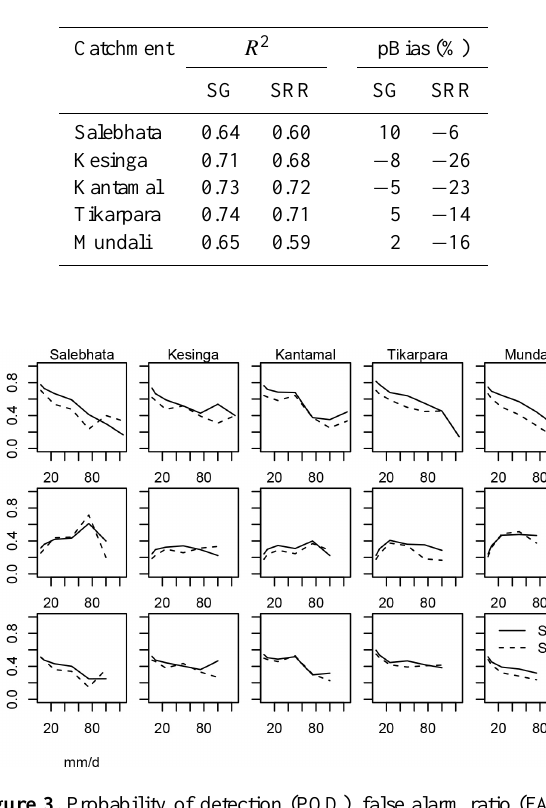
Table 8. Quality of daily areal precipitation estimates gained from gauge-adjusted TRMM data (SG) and raw real-time TRMM data (SRR). Reference: regionalised rain gauge data.